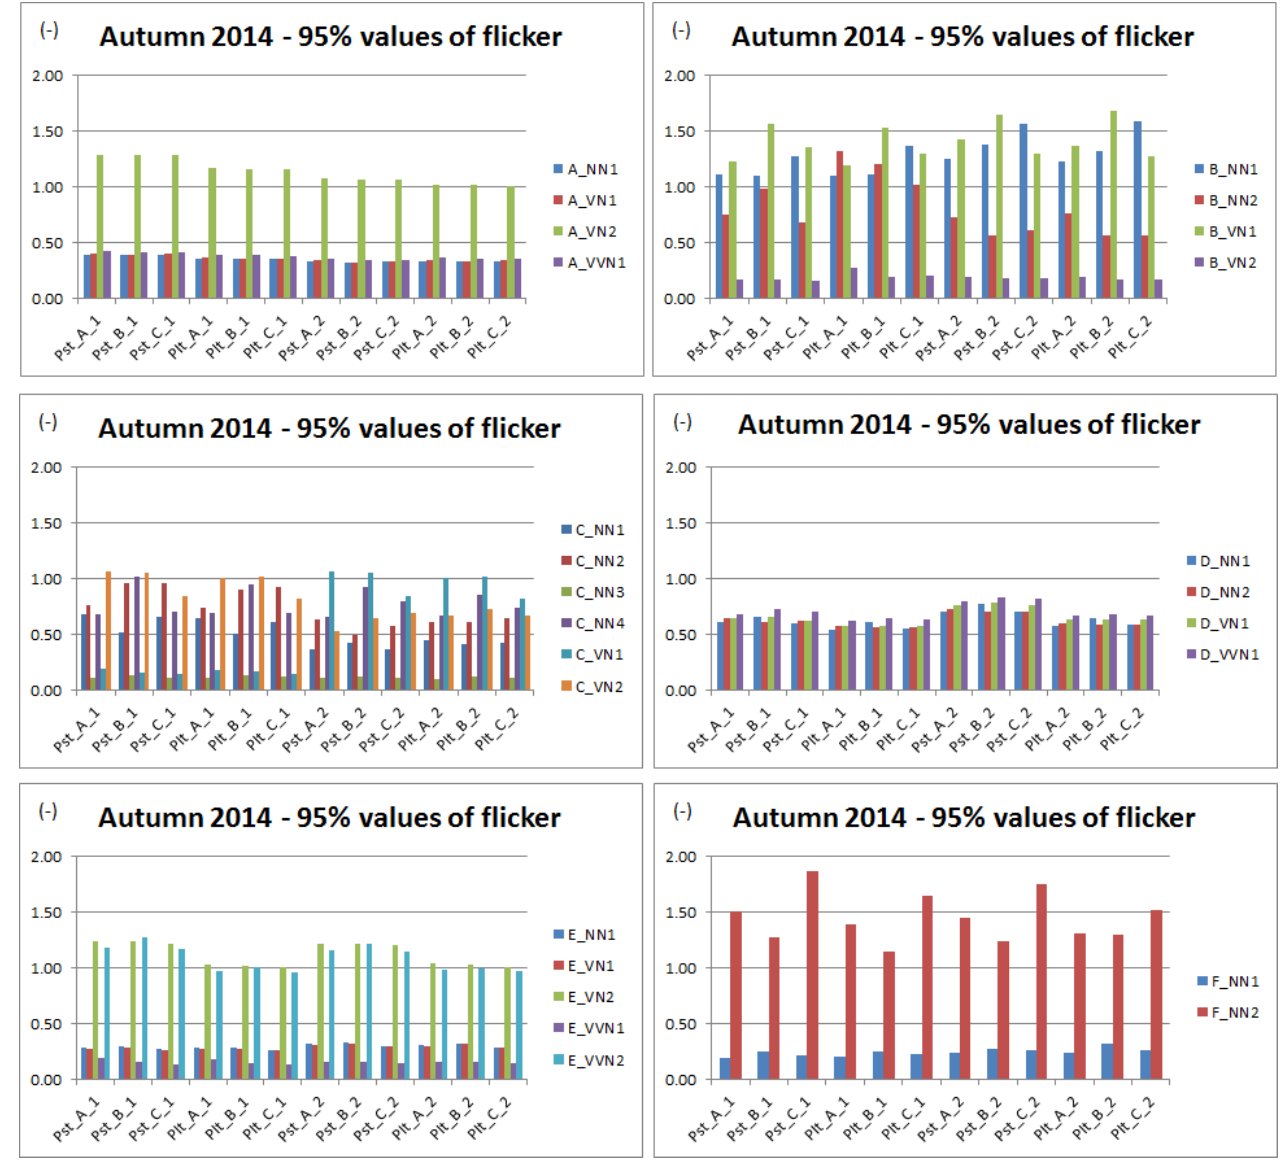
Fig. 6. The results of the measuring of flicker – Autumn